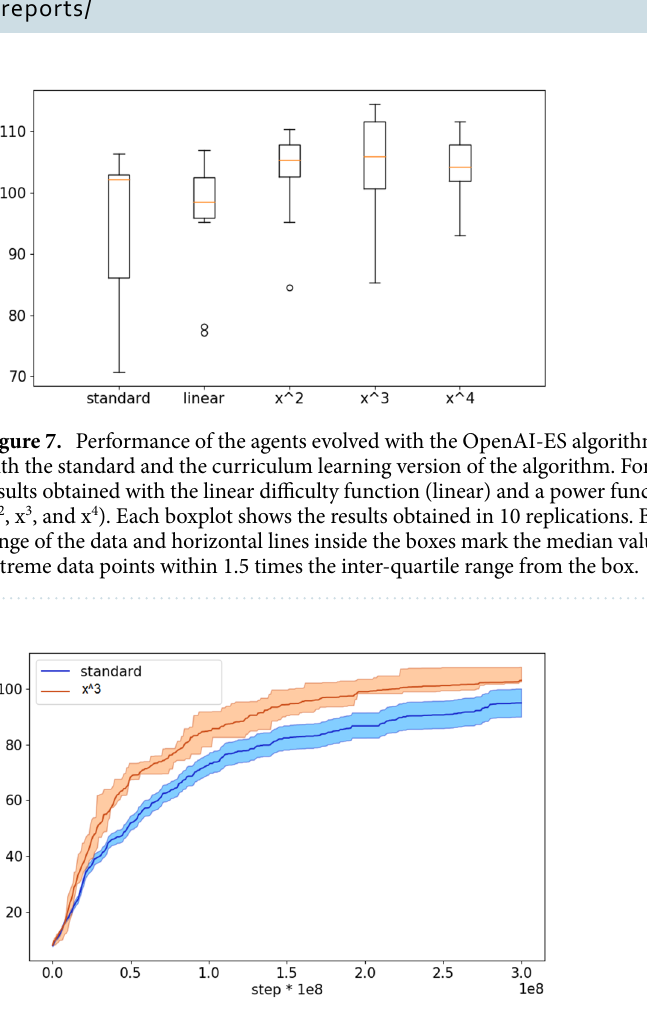
Figure 8. Performance during the evolutionary process of the agents evolved with the standard and with the curriculum learning OpenAI-ES algorithm. The latter refers to the experiments performed with the cubic function. The curves show the average results of 10 replications. The shadow indicate the 90% bootstrapped confidence